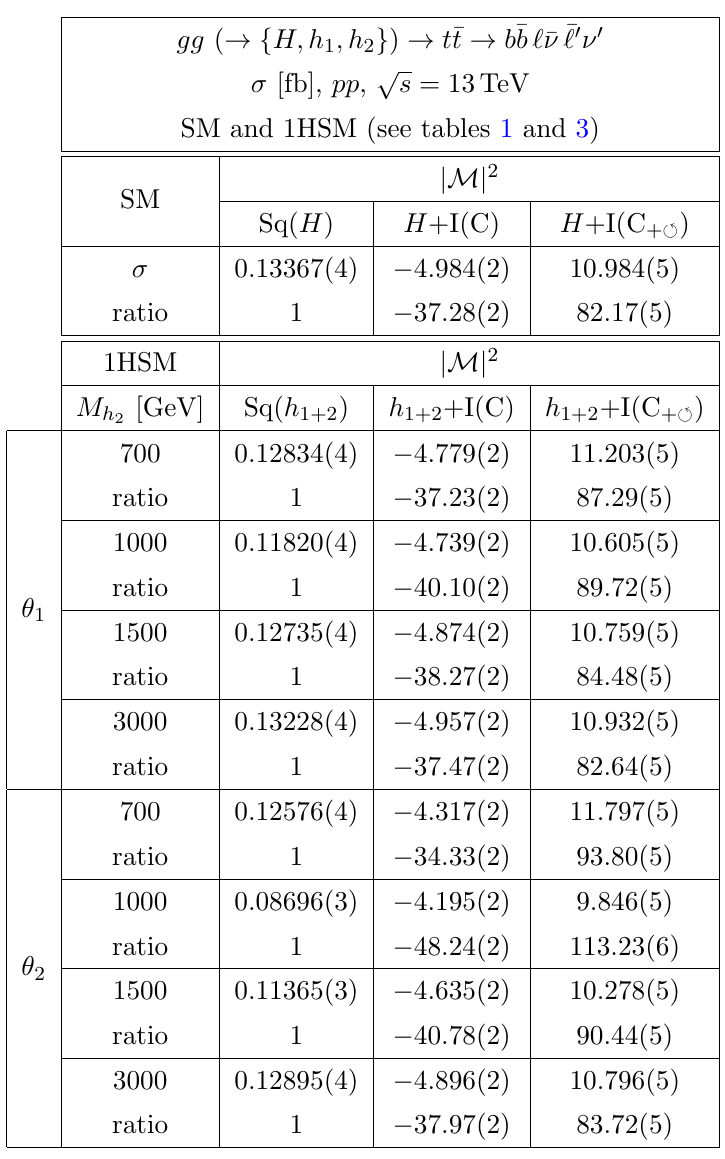
Table 6 . Cross sections for gg ( in the SM and 1HSM. Virtual corrections ( (cid:9) ) to the continuum background are taken into account (see main text). Other details as in table